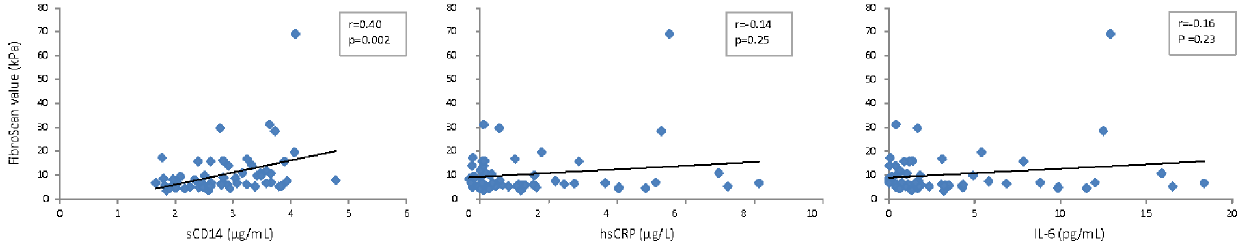
Figure 1. Correlation between FibroScan H values and inflammatory biomarkers (Spearman rank’s test). doi:10.1371/journal.pone.0059205.g001 PLOS ONE |